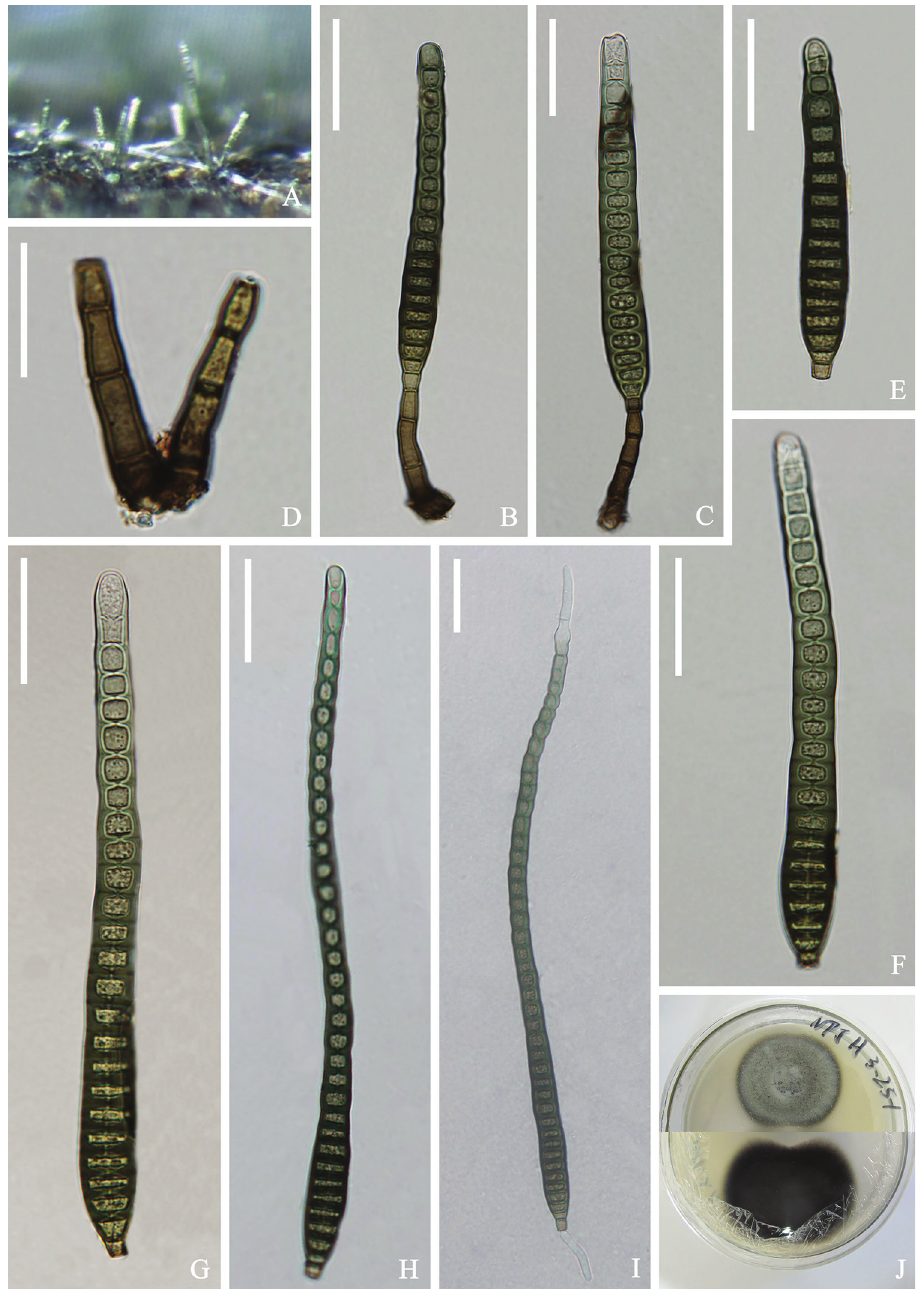
Figure 4. Distoseptispora clematidis (KUN-HKAS 112708) A colonies on the substratum B-C conidi- ophores with conidia D conidiogenous cells E-H conidia I germinating conidium J culture on PDA Scale bars: 30 μm ( B, C, E-I ); 20 μm ( D